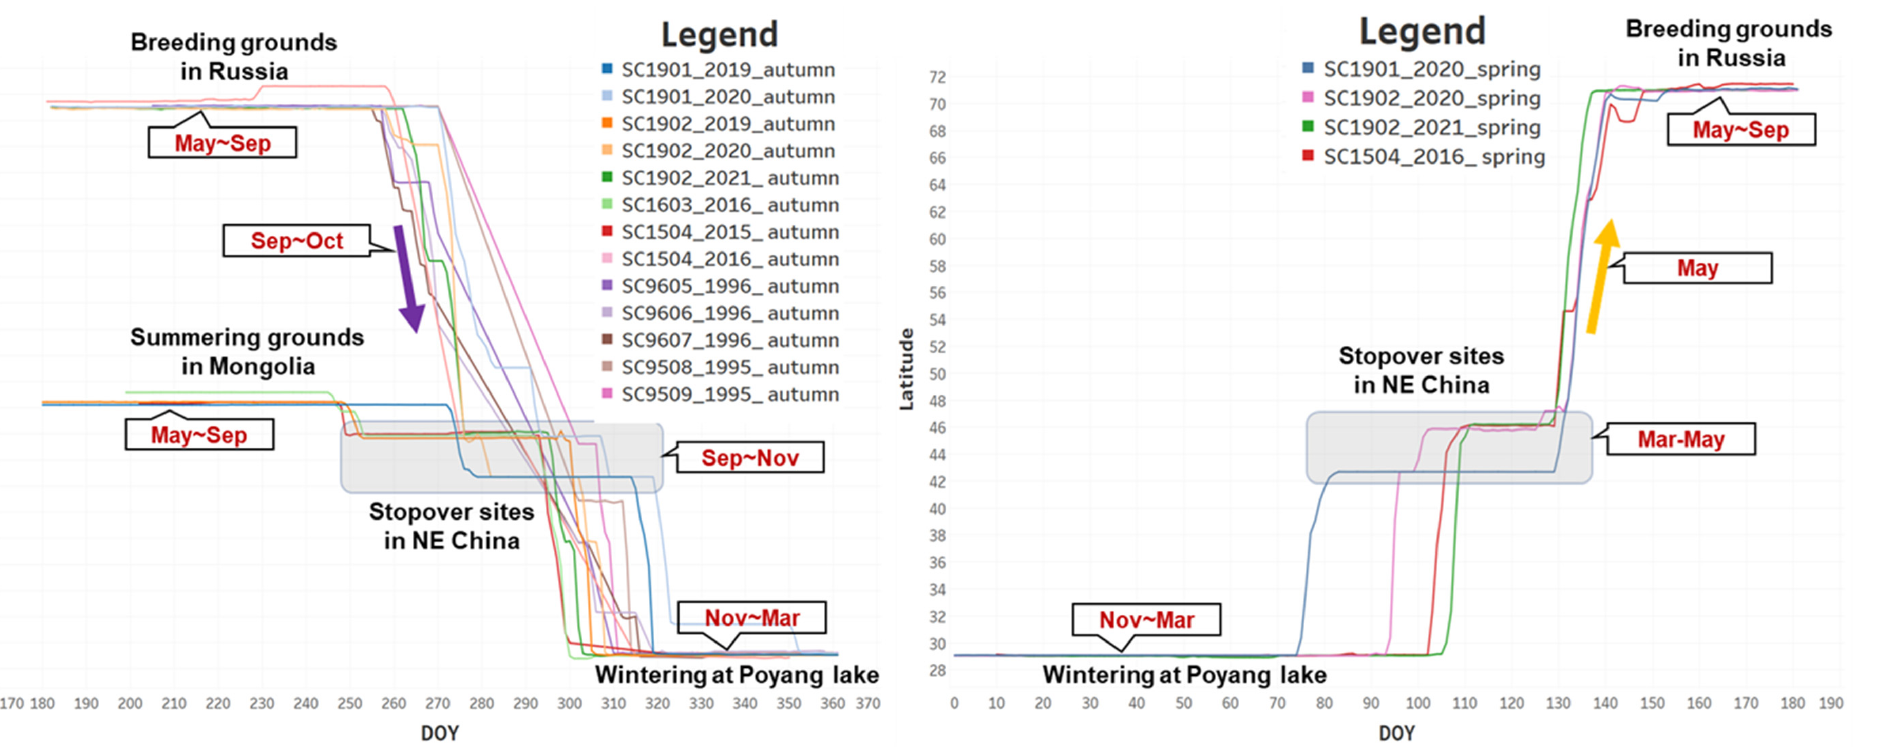
Figure 1. Schematic overview of movement patterns of the telemetered Siberian crane ( Leucogeranus leucogeranus ) followed from their breeding areas to the Poyang Lake wintering area (autumn migration (N = 13): left; spring migration: right (N = 4)). DOY abbreviation stands for the day of the year .